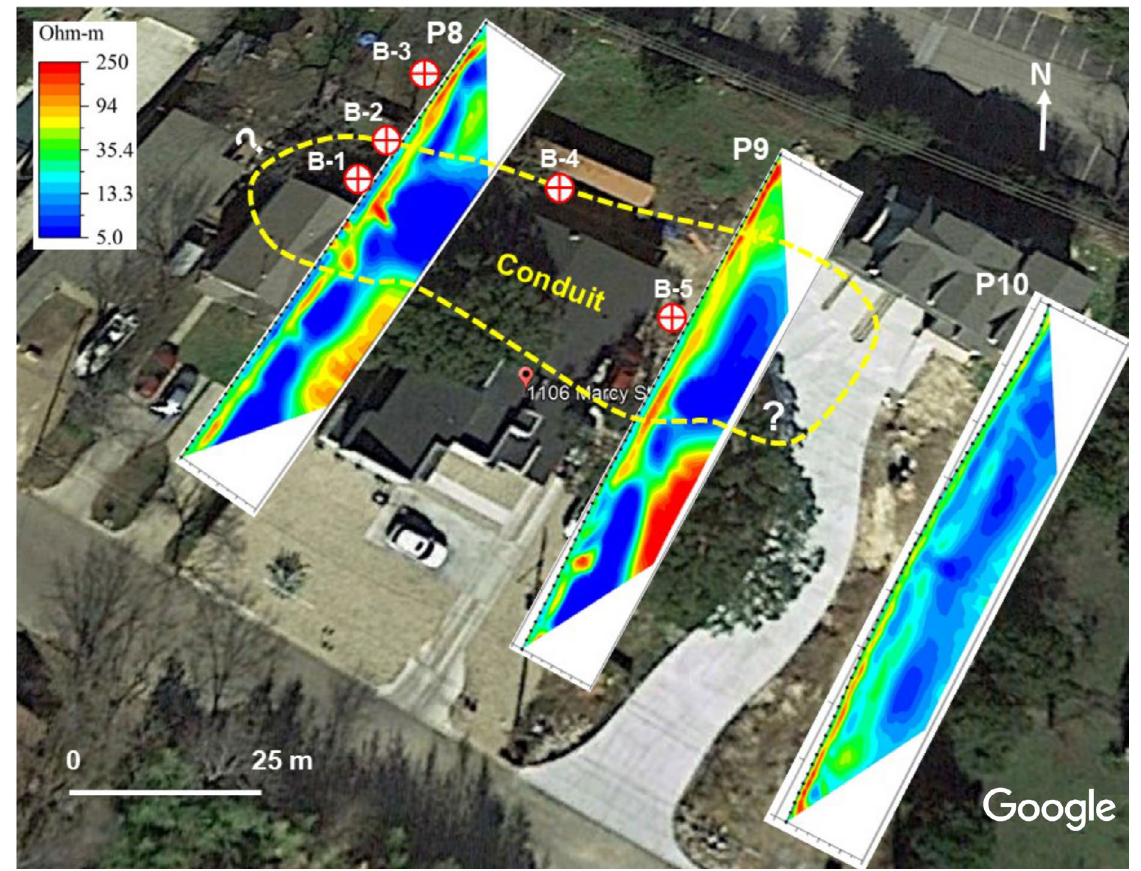
Figure 14: Resistivity profiles superimposed on a Google Map™ in the vicinity of the residential site. Note that the low resistivity anomaly is not observed on resistivity profile P10. White question marks indicate the possible extension of the conduit anomaly in the east and west directions. ©2019 Google LLC, used with permission. Google and the Google logo are registered trademarks of Google